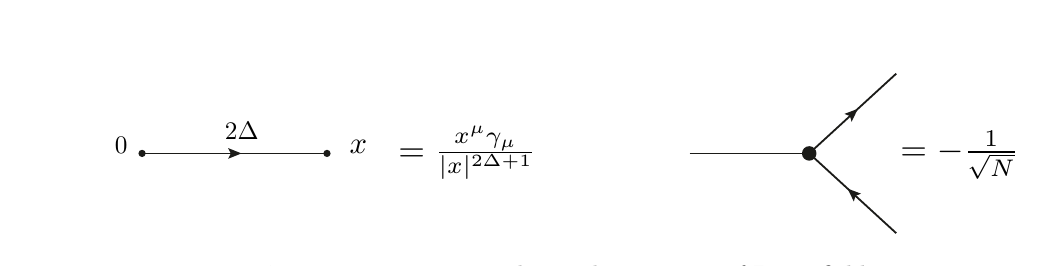
Figure 10 . Feynman rules in the presence of Dirac